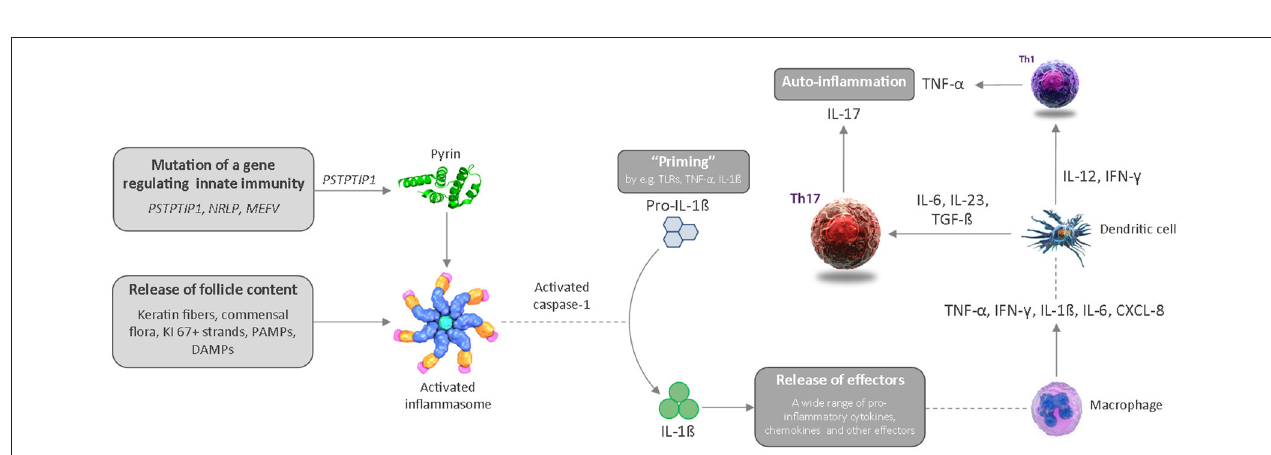
FIGURE 3 | Schematic diagram illustrating activation of the inflammasome in HS and related syndromes, which ultimately results in an auto-inflammatory immune response. CXCL, chemokine ligand; DAMP, danger-associated molecular pattern; IL, interleukin; IFN, interferon; PAMP, pathogen-associated molecular pattern; Th, T helper cell; TLR, toll-like receptor; TNF, tumor necrosis factor.